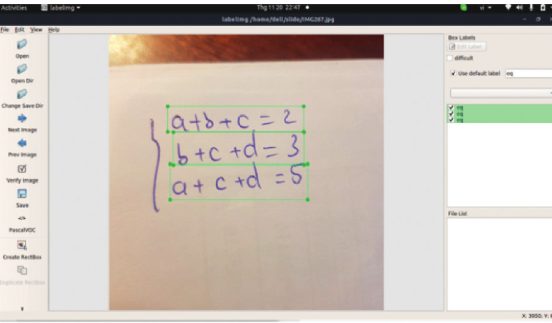
Figure 3: An example of labeling data.